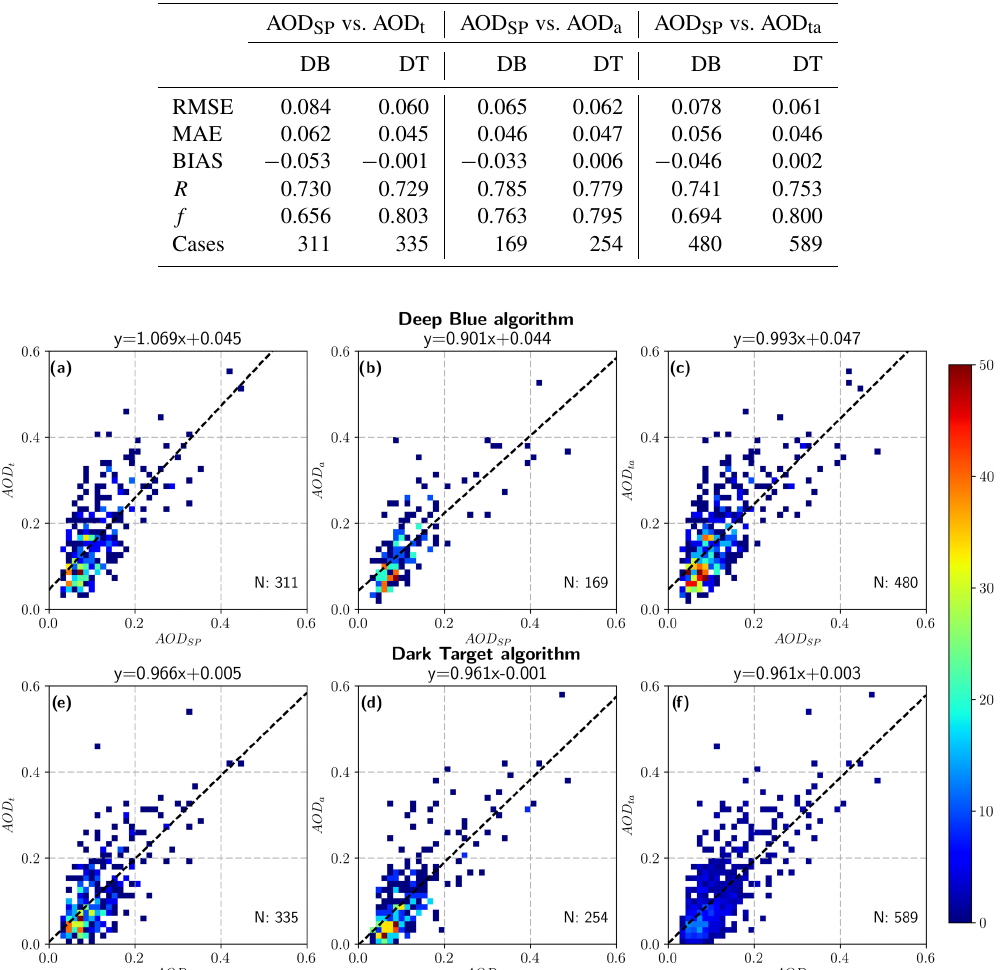
Table 4. Statistics from comparing collocated daily means of AOD t and AOD a with AOD SP and the combined AOD ta .